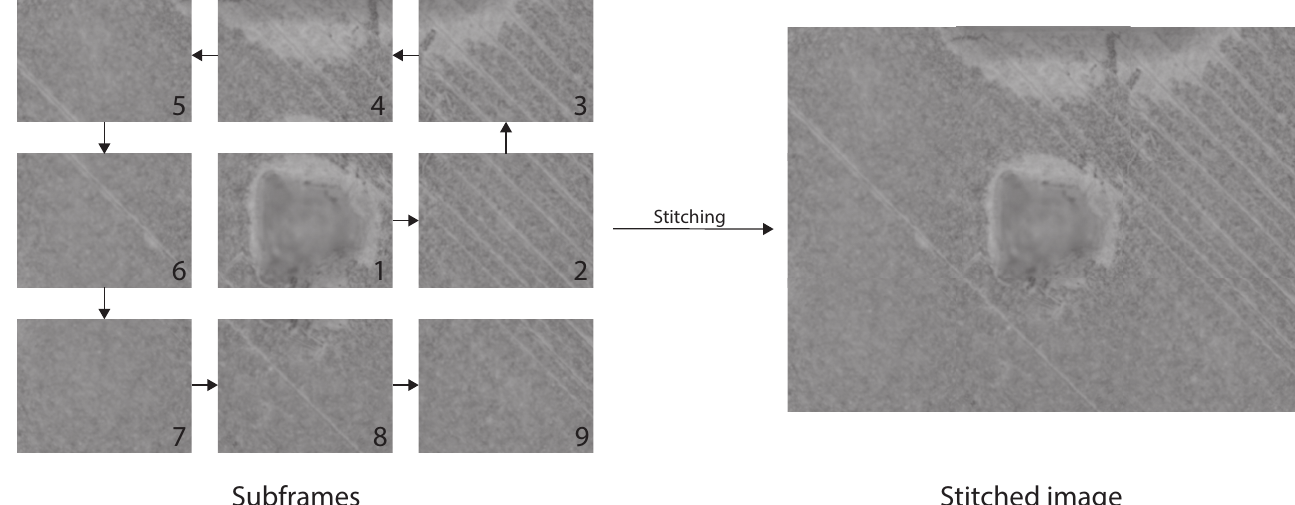
Figure 4. Principle of image stitching as implemented for this paper. Subframes ( left ) are taken counter clockwise with an overlap of 150 pixels and than stitched together to create an image of a larger area ( right